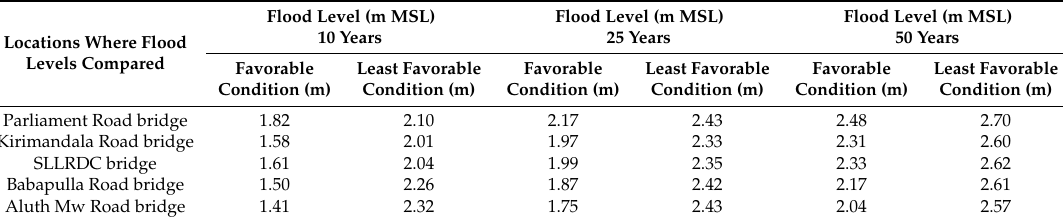
Table 4. Comparison of water levels for design rainfalls under favourable and least favorable conditions.